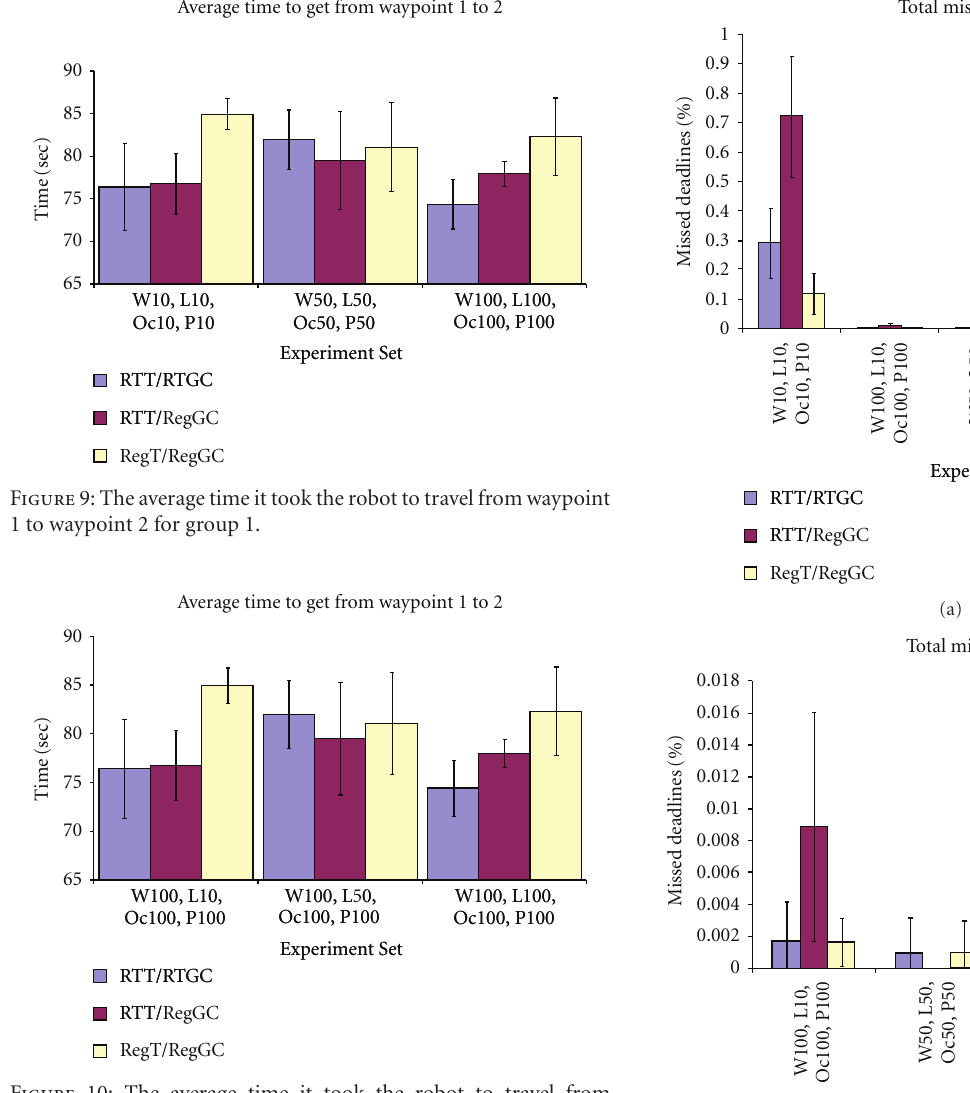
Figure 10: The average time it took the robot to travel from waypoint 1 to waypoint 2 for group 2.